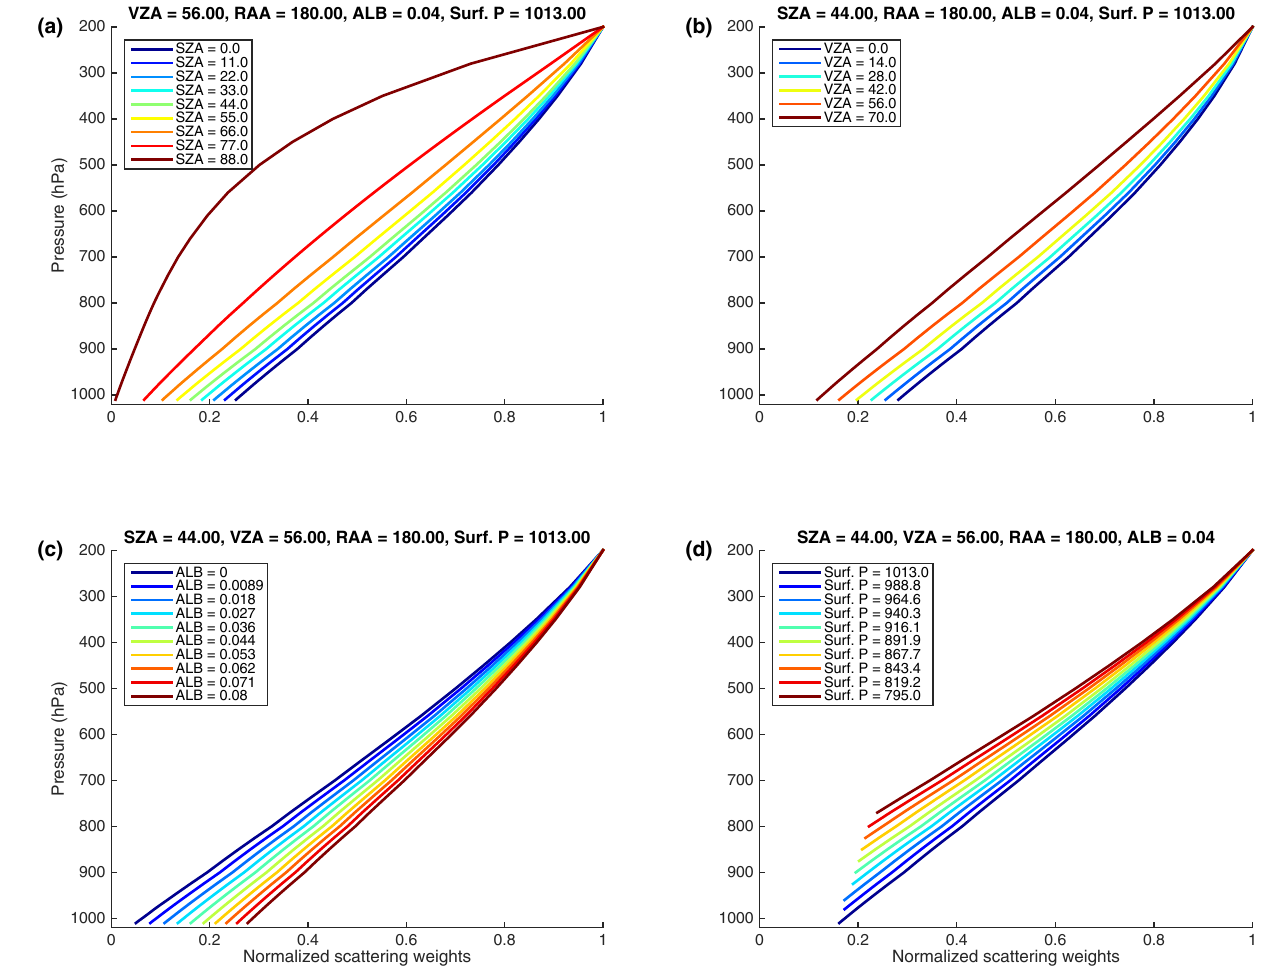
Figure 3. Vectors of scattering weights and their variation with each of the four most important lookup table input parameters. Values are representative of clear sky conditions. Each scattering weight vector is scaled so that the topmost entry is 1. Scattering weights are only shown above the surface